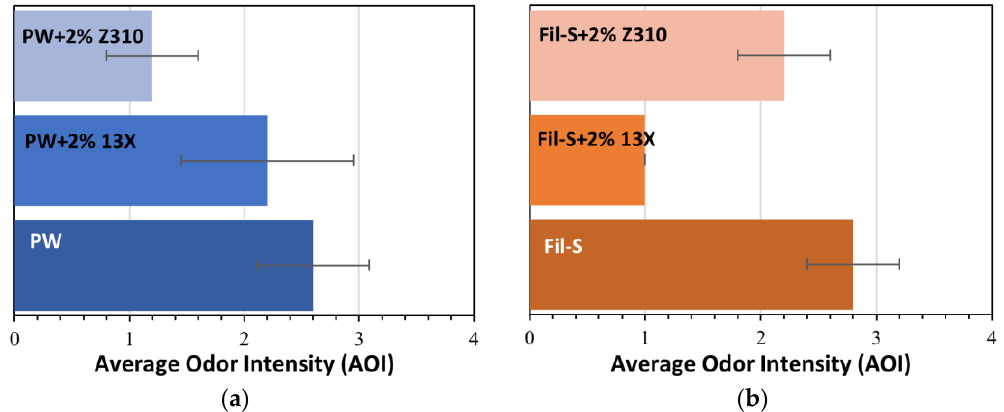
Figure 7. Results of the preliminary panel tests on ( a ) PW- and ( b ) Fil-S-based composite with the zeolites.